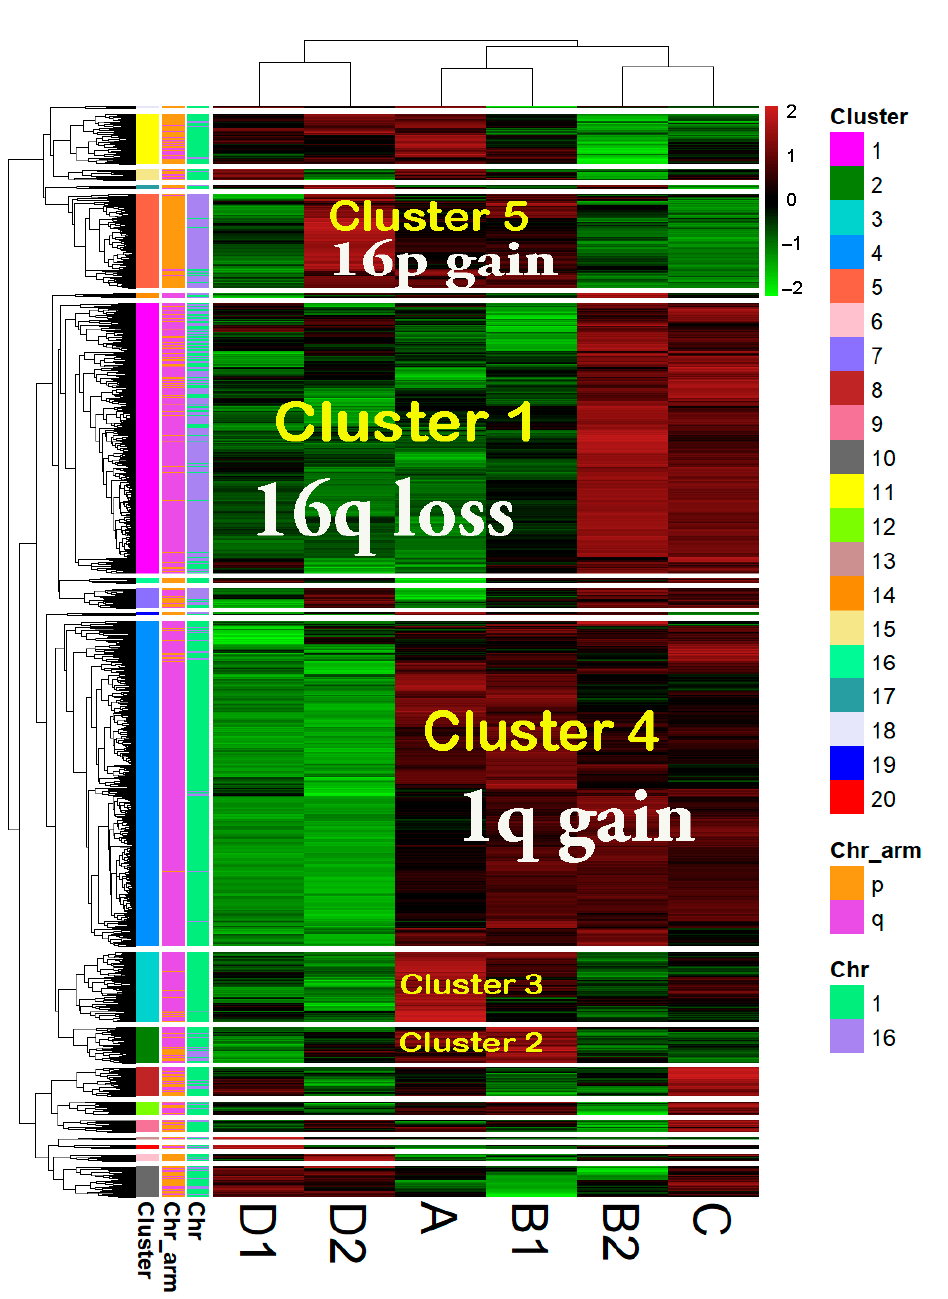
Figure 6. Hierarchical clustering of 1471 differentially expressed genes (DEGs) comparing group A vs. CTRL (FCvsCTRL > 1.3 or < − 1.3 at adjp < 0.001) Only DEGs located on chromosome 1 and 16 were used for analysis. The transformation of “linear FC” to “modified linear FC” (modified linear FC is equal to “linear FC-1” if linear FC > 1 or to “linear FC + 1” if linear FC < 1) was performed in order to avoid the gap between − 1 and +1 present in linear FC values. Data are clustered by the unweighted pair group method with arithmetic mean (UPGMA) with Euclidean distance. The common chromosomal abnormality among different groups is overwritten on the corresponding columns (in white letter). The cluster number is indicated by colors in the first column on the left and is repeated in some cases by overwriting the data columns (in yellow letters). Chr: chromo- some. The clustering at the gene level (rows in Figure 6) clearly showed the formation of clusters corresponding to gene expression changes concordant with copy number